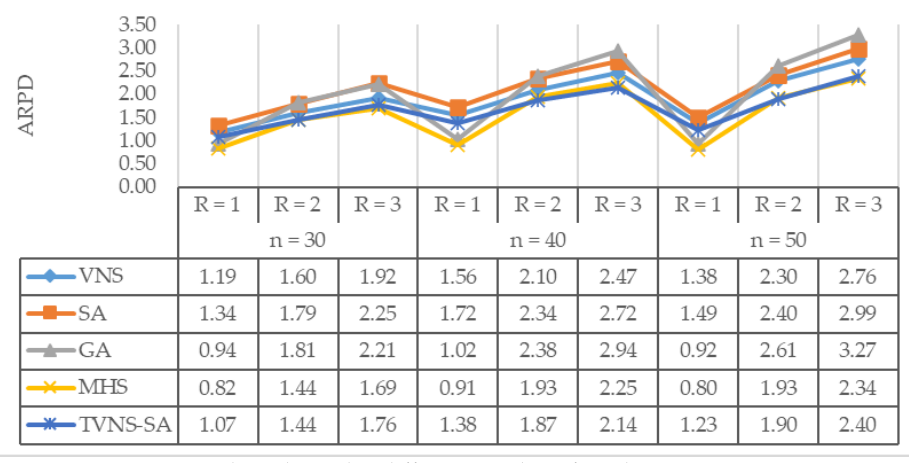
Figure 12. Computational results with a different number of machines.